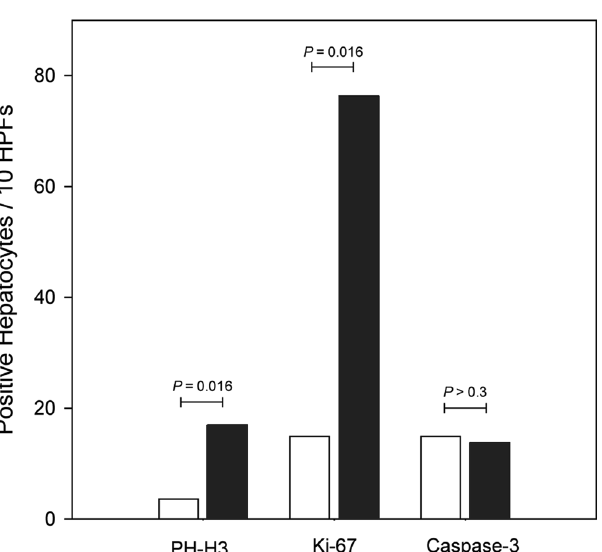
Figure 5. Hepatocellular mitosis (PH-H3), proliferation (Ki-67) and apoptosis (caspase-3) in hepatic tissue of control and irradiated pigs. The activity was estimated by counting the number of positive hepatocytes per 10 high-power-fields (HFPs). White bars are control pigs, black bars are irradiated pigs. Values are displayed as group medians; the groups were compared using the Wilcoxon rank sum test (n = 5 per